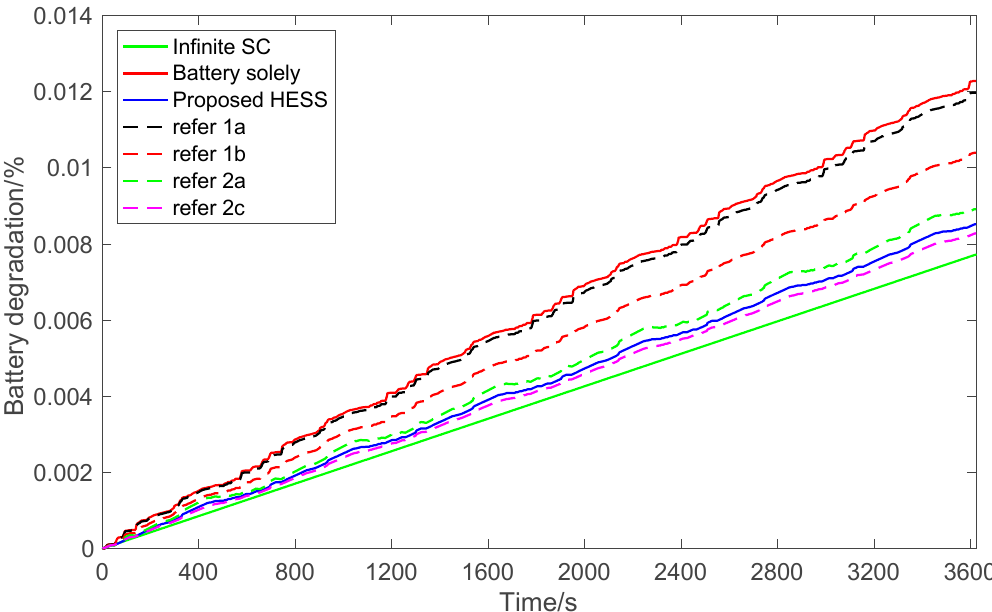
Figure 16. Battery degradation comparison in di ff erent